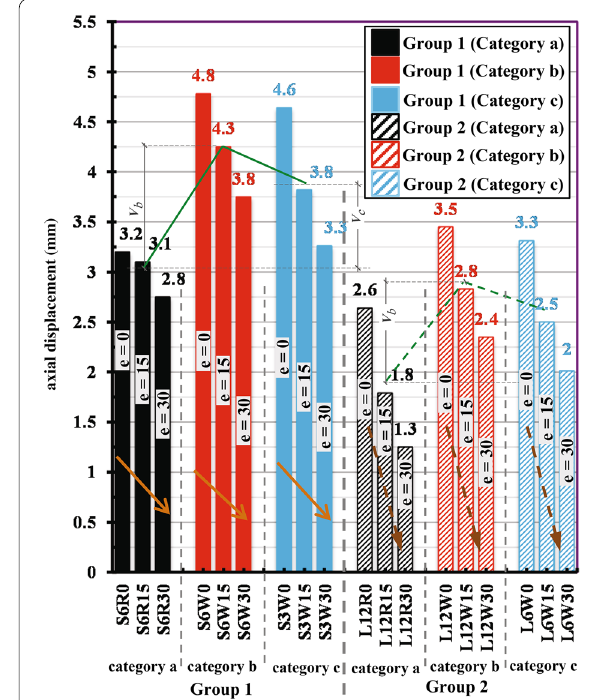
Fig. 11 Percentage increment in ultimate load Fig. 12 Axial displacement at ultimate load